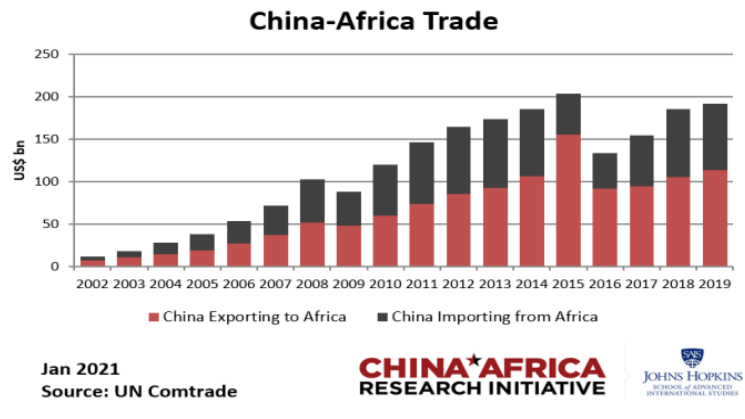
Figure 1: China-Africa